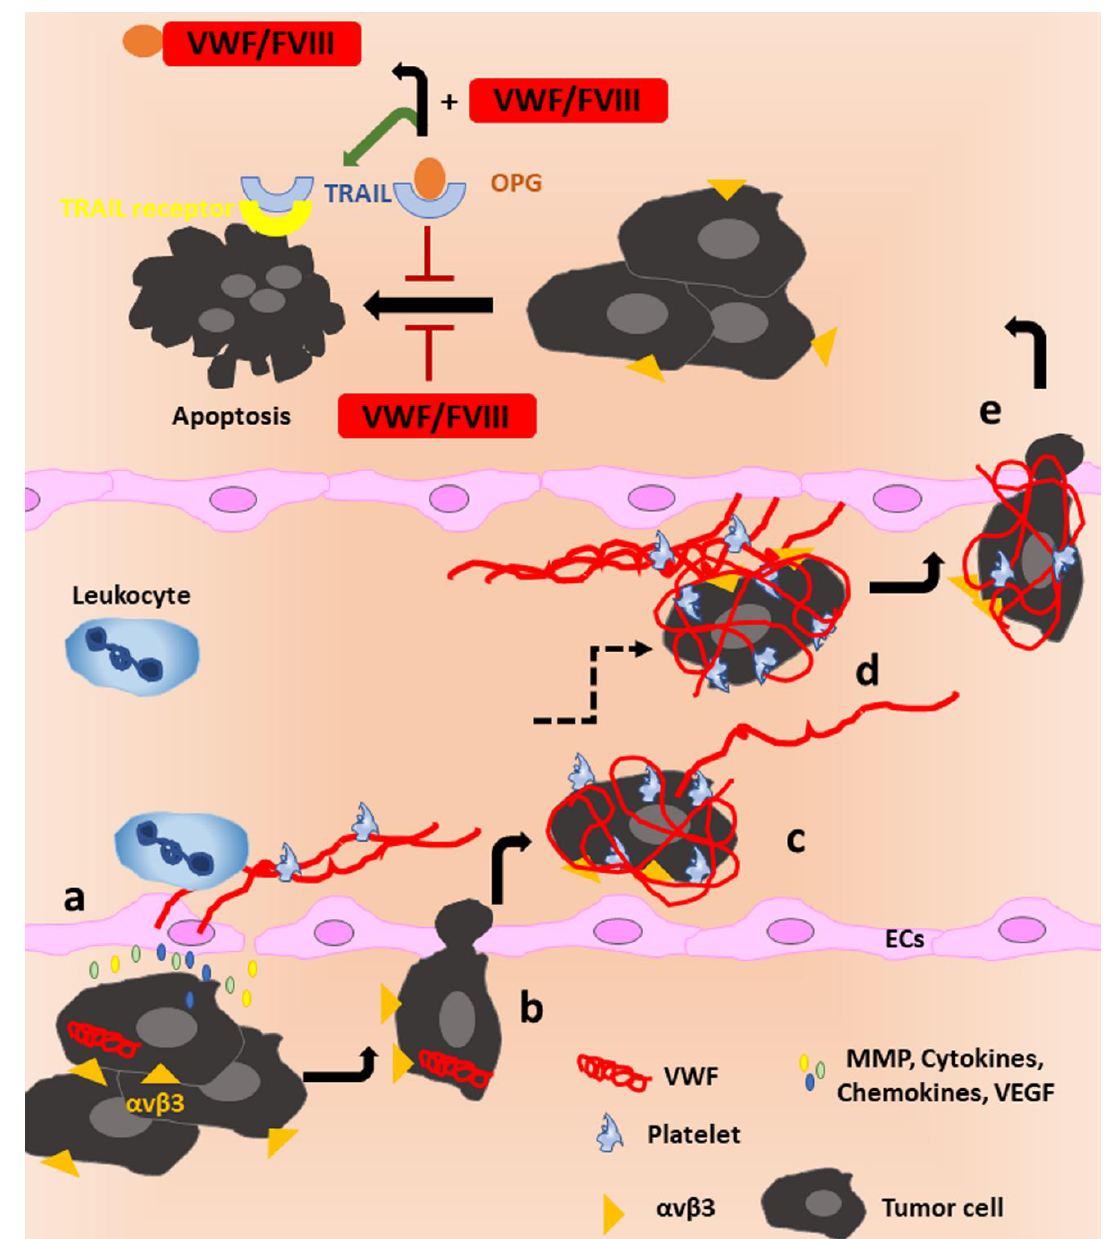
Figure 4. VWF’s role in tumor cell apoptosis and metastasis.Upper part: In the absence of the VWF – FVIII complex (red), OPG (orange) binds to Tumor necrosis factor-Related Apoptosis-Inducing Ligand (TRAIL, blue), leading to inhibition of tumor cell apoptosis. The presence of the VWF – FVIII complex functions as a decoy receptor for OPG, and TRAIL is released to interact with its receptor, inducing apoptosis of the tumor cell. If only VWF is present, it has anti-apoptotic properties, promoting tumor cell survival. Lower part: a : Tumor cells release a variety of proteins (matrix metalloproteinases (MMPs), vascular endothelial growth factor (VEGF), cytokines and chemokines) to induce disintegration of the subendothelial extracellular matrix and to activate the endothelium. ECs then release ultra-large (UL-)VWF, increasing the VWF antigen and promoting the formation of platelet-decorated strings as well as recruitment of leukocytes. b : The resulting proinflammatory cytokine signaling, enhanced angiogenesis, and altered vascular permeability create a premetastatic environment, promoting tumor growth and the transmigration of tumor cells through the endothelium into the blood stream. c : The metastatic cells can bind VWF via integrin α v β 3 and shield themselves from detection by immune cells by cloaking themselves in a shell of VWF and platelets. Some tumor cells acquire the ability to produce VWF to further potentiate these effects. d : Interaction of tumor cells with VWF and platelets may further support adhesion to the vessel wall, helping the cells to initiate e : extravasation to the metastatic site.